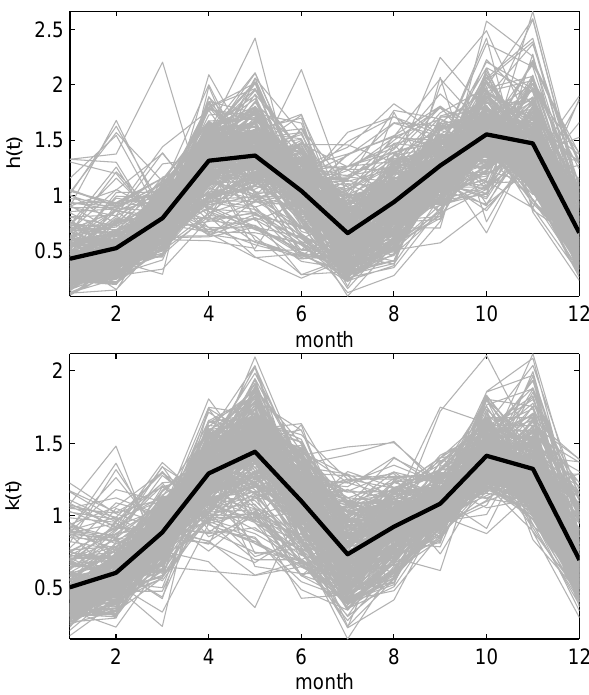
Fig. 5. Non-dimensional monthly average rainfall intensity h(t) and rainfall rate k(t) for 294 gauging stations in North-Western Italy (grey lines). The overall spatial mean values are reported in black.